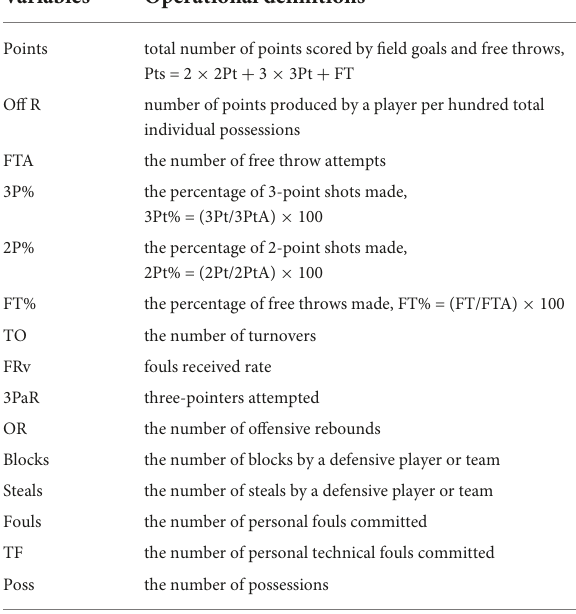
TABLE 1 Performance-related